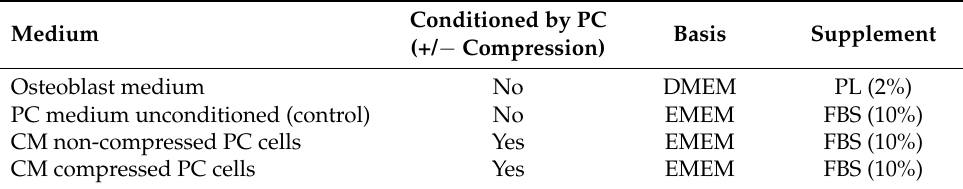
Table 3. Osteoblastogenesis